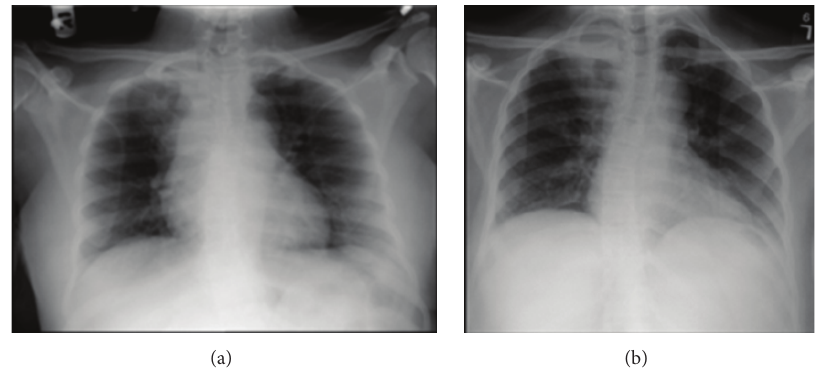
Figure 1: Chest imaging prior to anti-TB therapy and during TB therapy. (a) CXR showing nodular opacity in the apex of the lung fields and (b) CXR showing increased density in the right upper